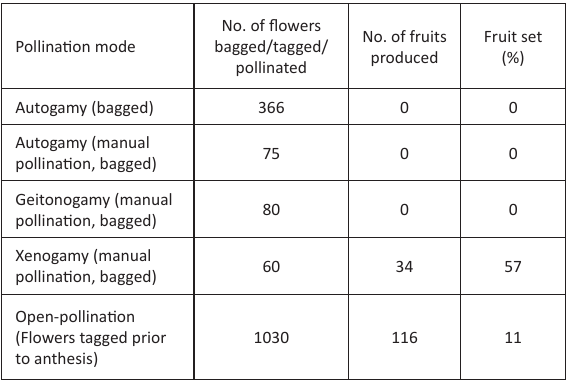
Table 2. Results of breeding systems in Syzygium